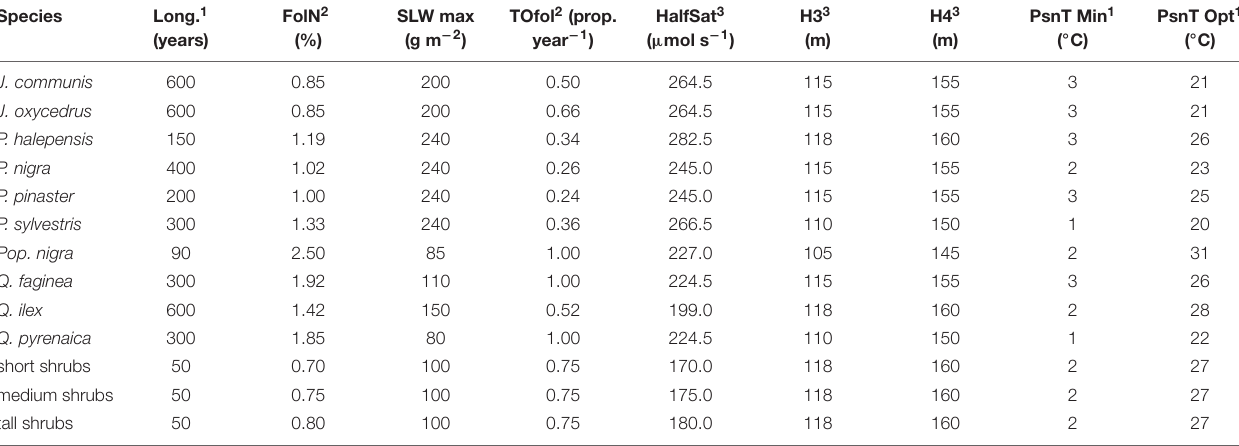
TABLE 2 | Species parameter values for LANDIS-II and PnET-Succession.